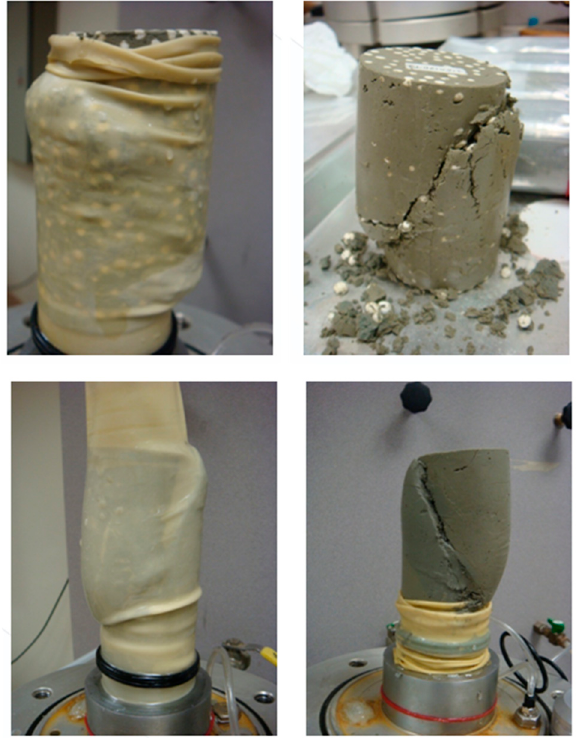
Figure 9. Shear failure for the lower E/S ratio.